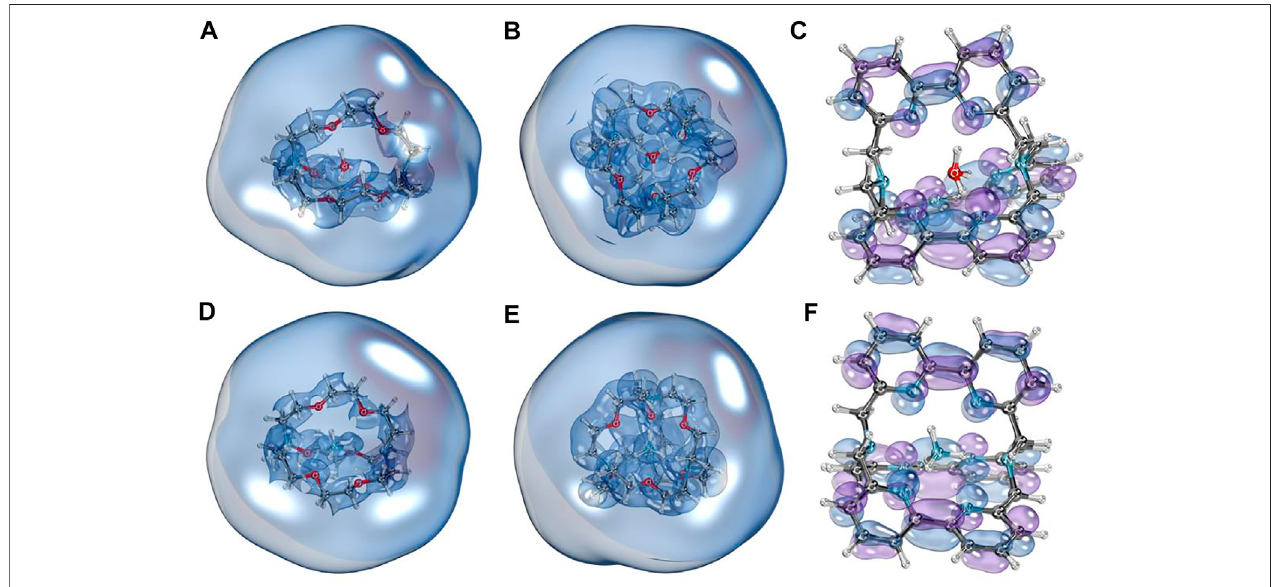
FIGURE2| IsosurfaceplotsofsinglyoccupiedmolecularorbitalsofNH 4 andH 3 Ocomplexes. (A) [H 3 O ⊂ [2.2.2]cryptand]; (B) [H 3 O ⊂ sphericalcryptand]; (C) [H 3 O ⊂ [bpy.bpy.bpy]cryptand]; (D) [NH 4 ⊂ [2.2.2]cryptand]; (E) [NH 4 ⊂ spherical cryptand]; (F) [NH 4 ⊂ [bpy.bpy.bpy]cryptand]. A threshold of 100% was used for A, B, D, E to illustrate the diffuse nature of those orbitals. For C and F a lower 80% threshold was used for visualization.